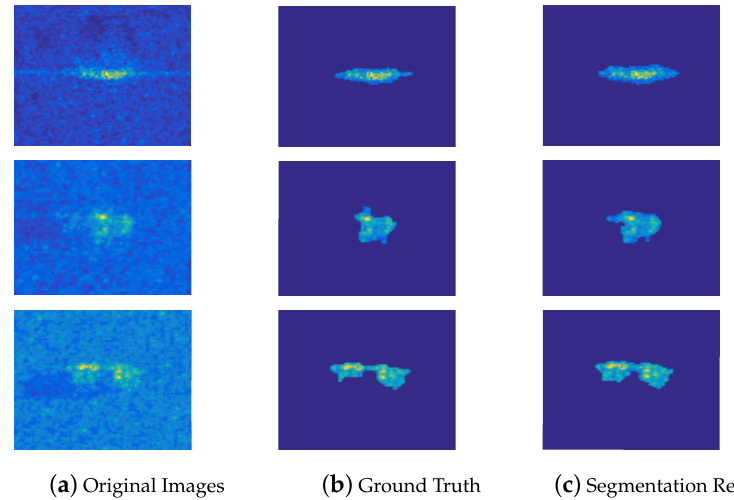
Figure 3. Three randomly selected samples to show the segmentation performance. Each row represents one sample including original image, ground truth, and segmentation result (from left to right ).